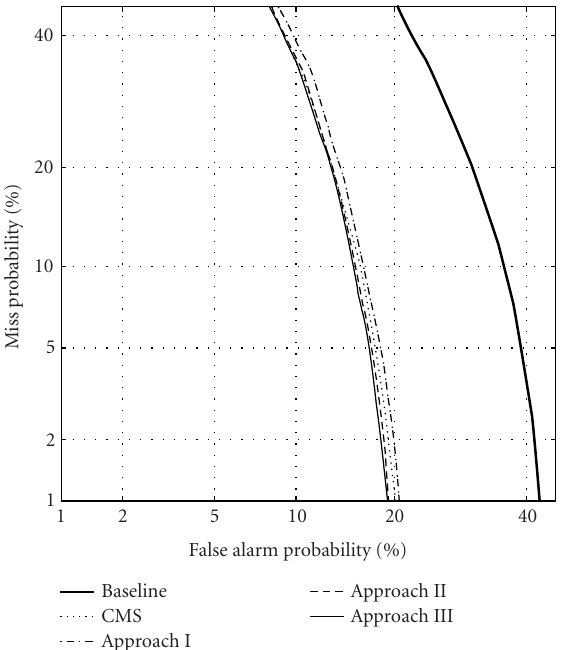
Figure 7: DET curves obtained by using the unseen handset cb3 in the verification sessions. Handsets cb3 and el2 were used as the unseen